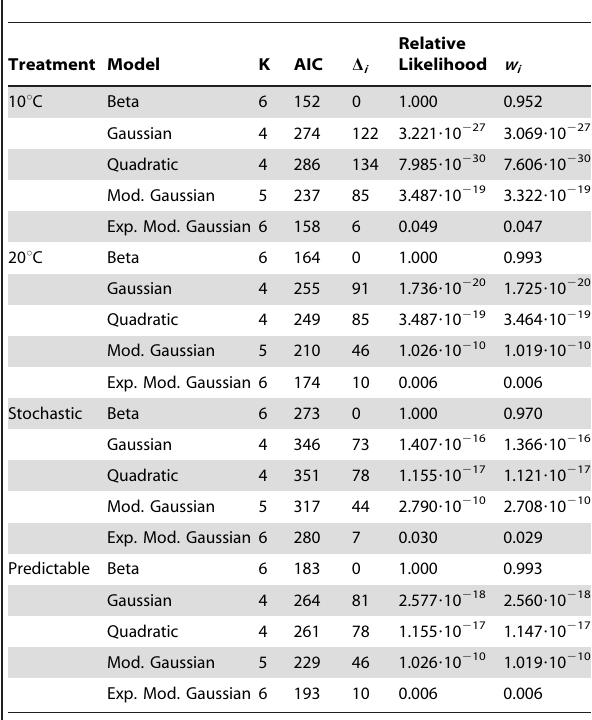
Table 1. A comparison of plausible models of the relationship between body temperature and running speed in isopods from four thermal treatments.